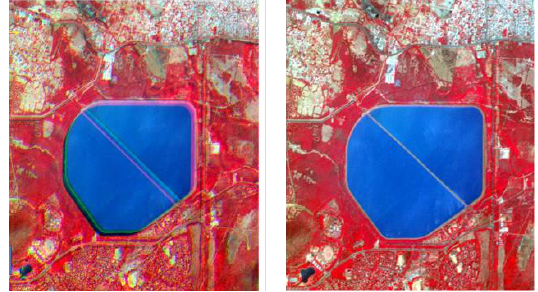
Figure 2 Band to band mis-registration in the L4 product due to an error in the attitude restitution (left) and product after reconstructing the platform attitude with GCPs (right)